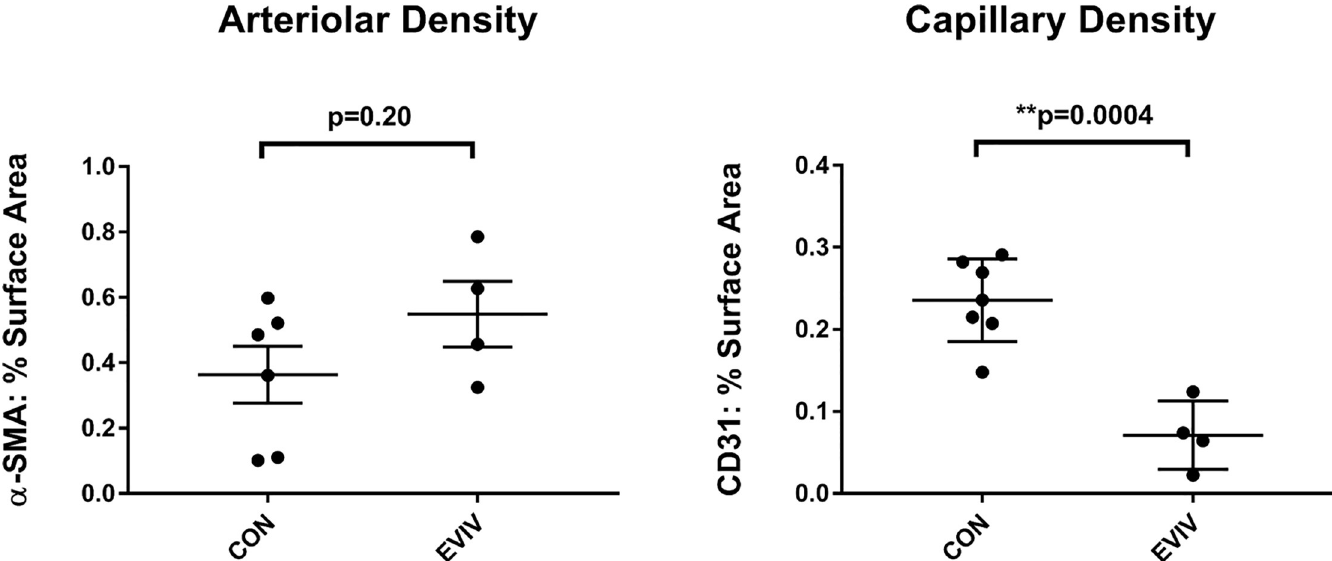
Fig 7. Vascular density as a measure of angiogenesis. There was no difference in arteriolar density between groups and rather a decrease in capillary density. CON: Control group, EVIV: Extracellular Vesicle Intravenous injection group, �� p < 0.01 via Unpaired t-test.